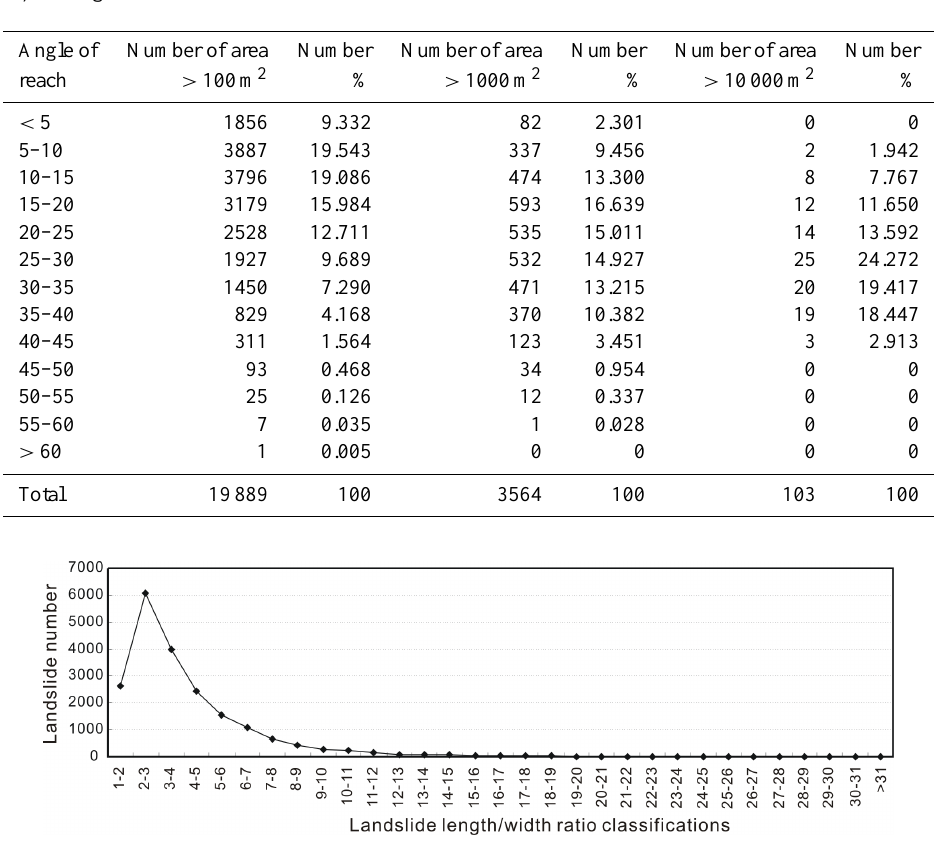
Table 2. Landslide number and landslide number percentage in different angle of reach of three conditions, including area larger than 100m 2 , larger than 1000m 2 , and larger than 10000m 2 .